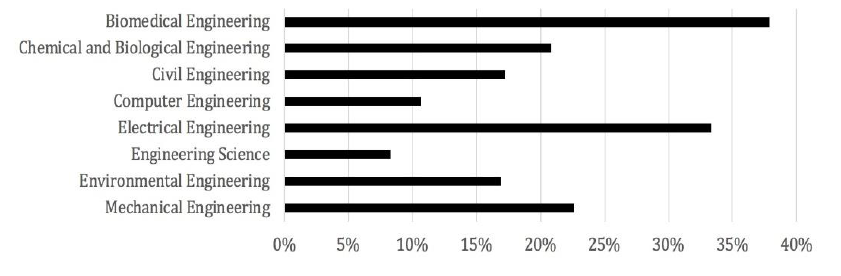
Fig. 2. Response rate by